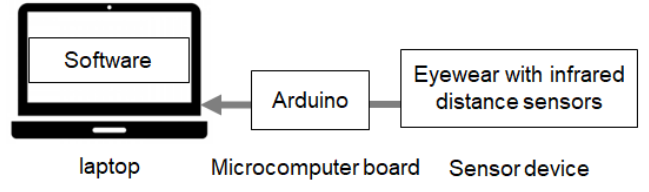
Figure 2. System